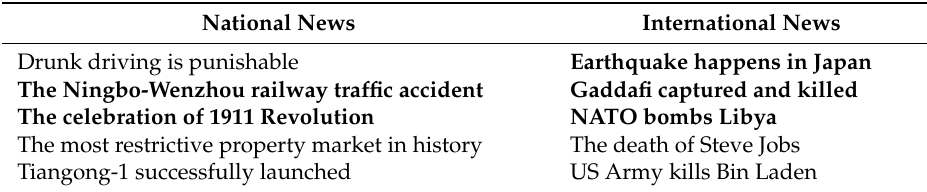
Table 4. Hot news summarized by the Xinhua News Agency.